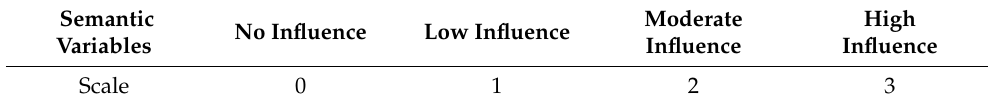
Table 2. Expert commentary on semantic